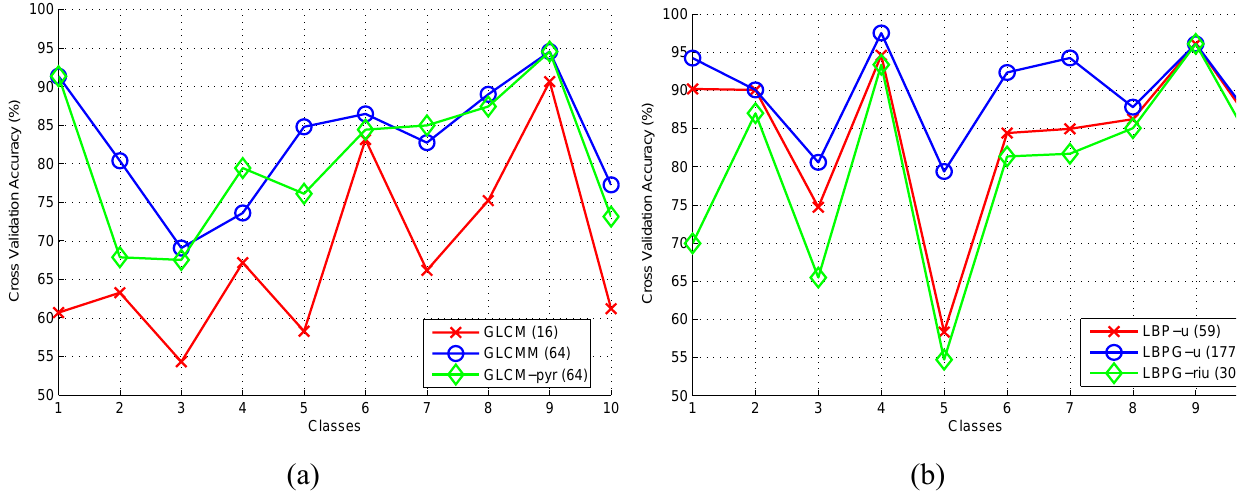
Figure 17. Cross validation accuracy (%) of ( a ) GLCM and ( b ) LBP configurations. Note that labels include the vector